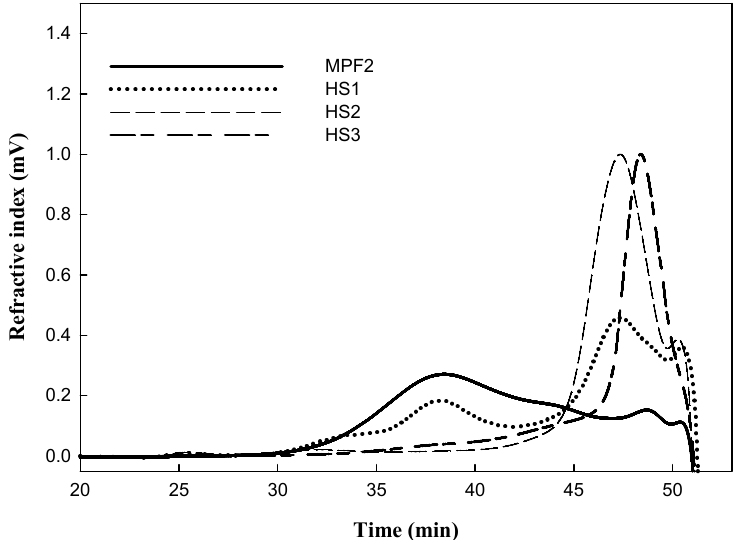
Figure 3. The HPSEC chromatograms of MPF2 and hydrolysed polysaccharides at 100 °C for 5 min (HS1), 10 min (HS2) and 15 min (HS3).